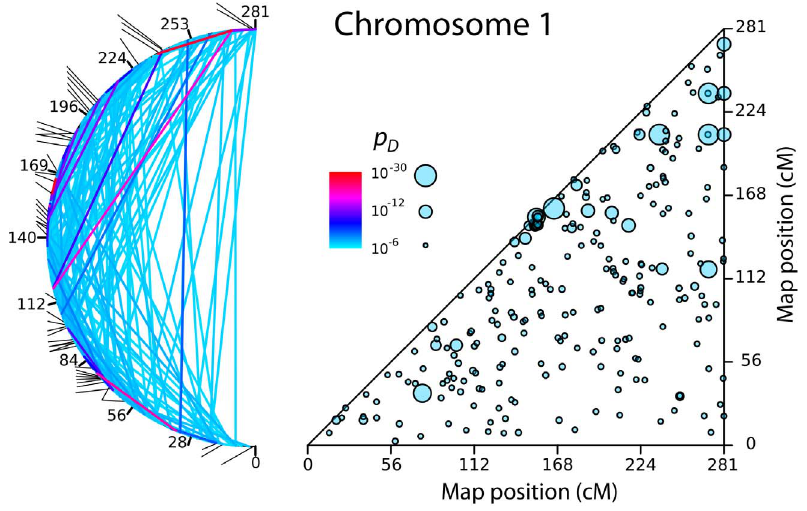
Figure 3. Patches of LRLD on Chromosome 1. Left: The circle plot represents patches by lines that connect the chromosome blocks involved. The most extreme value of p D in each patch is represented by the color of the segment. The line segments on the outside of the circle show regions identified in Akey’s [36] catalogue of genomic targets of positive selection. Right: The triangle plot shows the patches as circles whose size is scaled to the value of the most extreme value of p D in that patch. doi:10.1371/journal.pone.0080754.g003 PLOS ONE |